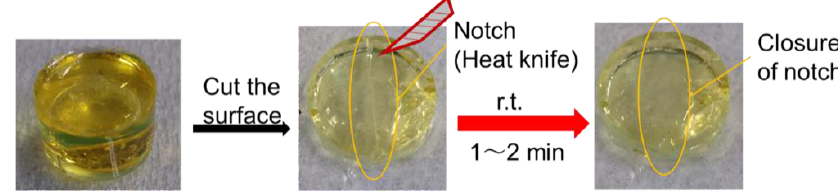
Figure 3. Rapid self-healing process of PU-1 gel surface cut by a heated knife.